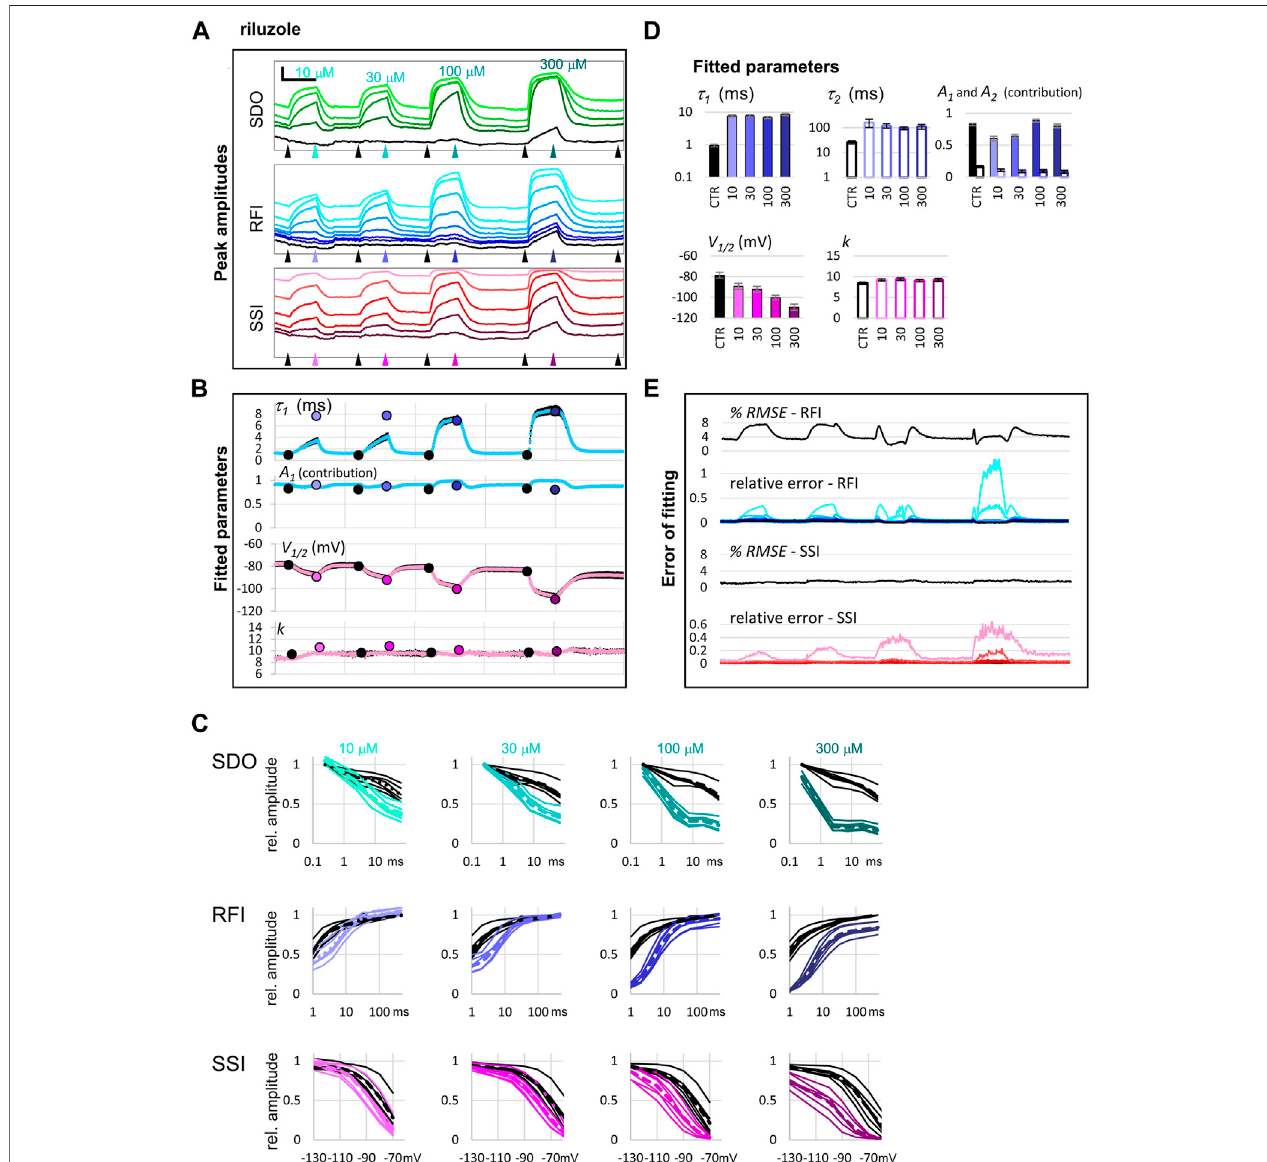
FIGURE 6 | The effect of four different concentrations of riluzole on peak amplitudes. (A) An example of peak amplitude plots for all 17 pulse-evoked currents, grouped into the SDO , RFI , and SSI groups as shown in Figure 2 . Scale bars: 4 nA, 50 s. Arrowheads indicate the time points immediately before, and at the end of drugperfusionperiods.Ateachpoint,indicatedbythearrowheads,theaverageofthreeconsecutivedatapointswastakentoconstructtheplotsshowninpanel (C) .(B) Parameters of Boltzmann, and bi-exponential automated fi ts throughout the four drug application periods. Colored circles indicate the values obtained by visually controlled fi ttingof n (cid:2) 6curves;thesamedatathatisshowninpanel (C) . (C) Reconstructed SDO , RFI ,and SSI plotsfor n (cid:2) 6cellensembles.Colorsmatchthecolorsof arrowheadsinpanel (A) . Dottedlines show theaverageofthesixcellensembles. (D) Parameters obtainedbyvisuallycontrolled fi ttingofRFIand SSIplots. ForRFI plots Eq. 5 was used, with the constraint of x (cid:2) 1. (E) The error of fi tting throughout the four drug application periods. RMSE values are expressed as the percentage of the peakamplitudeevokedbypulse#1ofthesamesweep.Relativeerrorsareshownforpulses#6 – #12and#1(shadesofblueandblack,asshowninpanel (A) ),aswellas for pulses #12 – #17 (shades of red, as shown in panel (A)